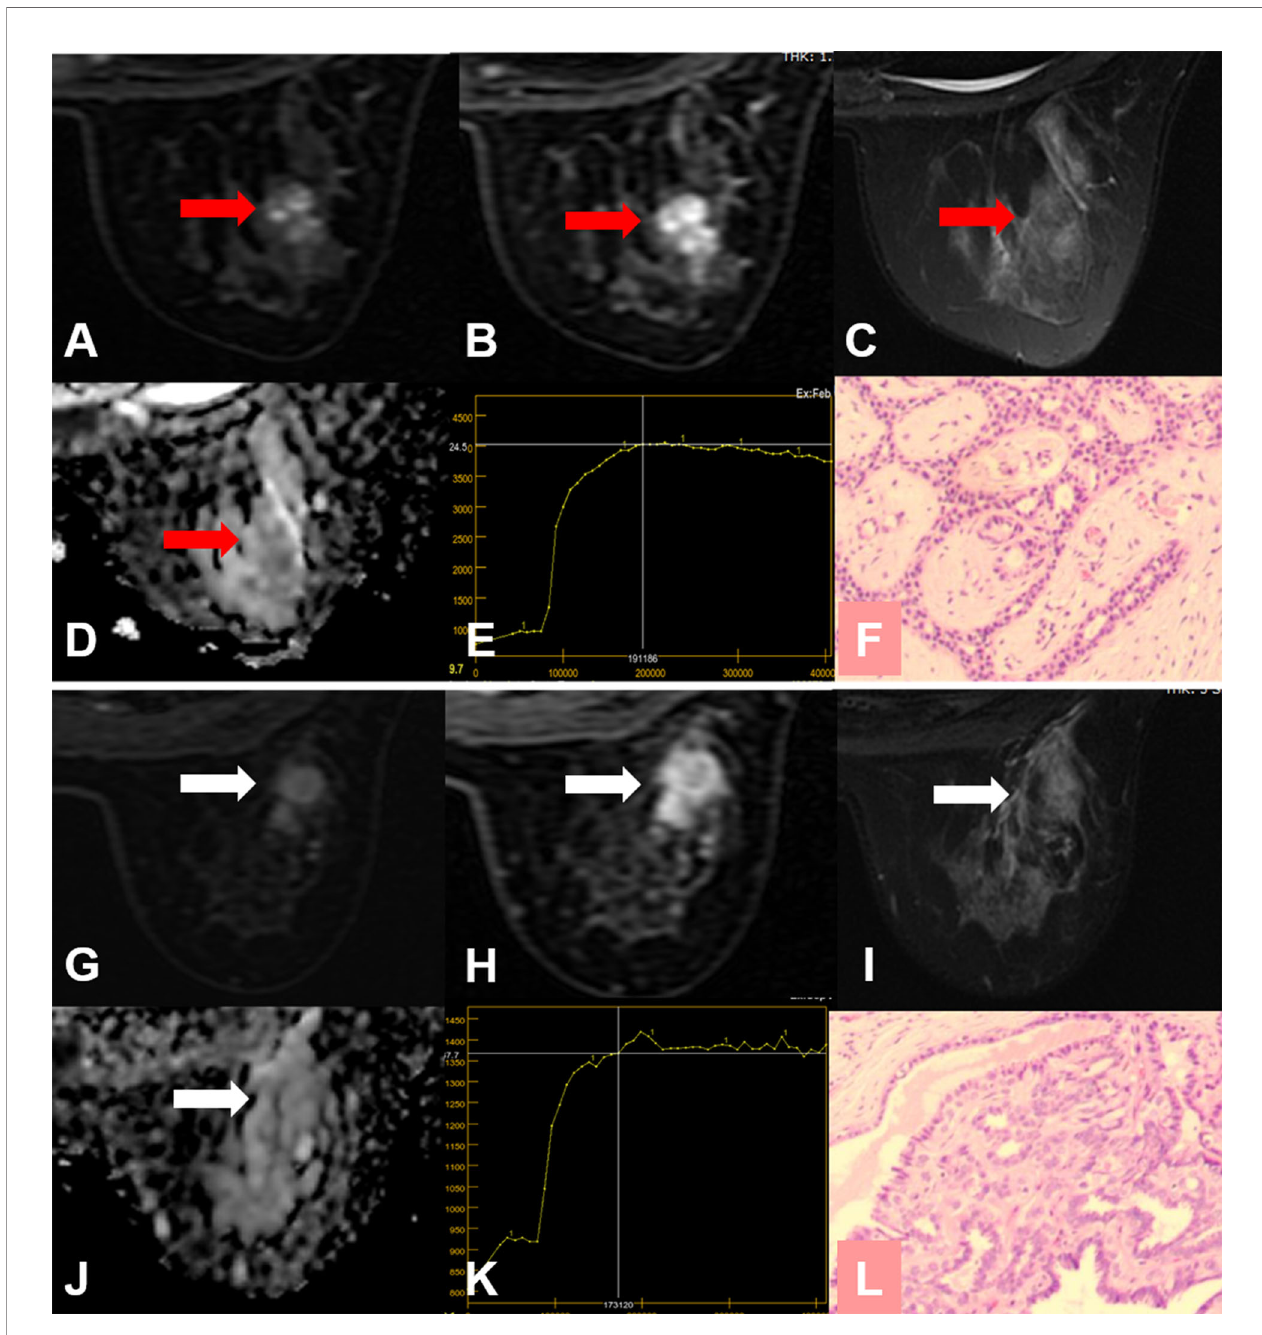
FIGURE 6 | False-positive KS and true-negative KS+ results. (A – F) A 24-year-old female patient: MRI showed a mass lesion in the right breast [ (A – D) , red arrow]. The lesion showed no root sign, a plateau enhancement curve type (E) , and irregular margins (A, B) . (A) Early contrast-enhanced MRI, (B) delayed contrast-enhanced MRI, (C) T2WI with fat suppression, (D) ADC map, (E) TIC curve, (F) pathological image (H&E, 100×). Kaiser score = 5, ADC = 1.67 × 10 − 3 mm 2 /s. Histopathology revealed a fi broadenoma (F) . (G – L) A 50-year-old female patient: MRI showed a mass lesion in the right breast [ (G – J) , white arrow]. The lesion showed no root sign, a plateau enhancement curve type (K) , and irregular margins (G , H) . (G) Early contrast-enhanced MRI, (H) delayed contrast-enhanced MRI, (I) T2WI with fat suppression, (J) ADC map, (K) TIC curve, (L) pathological image (H&E, 100×). Kaiser score = 5, ADC = 1.65 × 10 − 3 mm 2 /s. Histopathology revealed a papilloma (L)